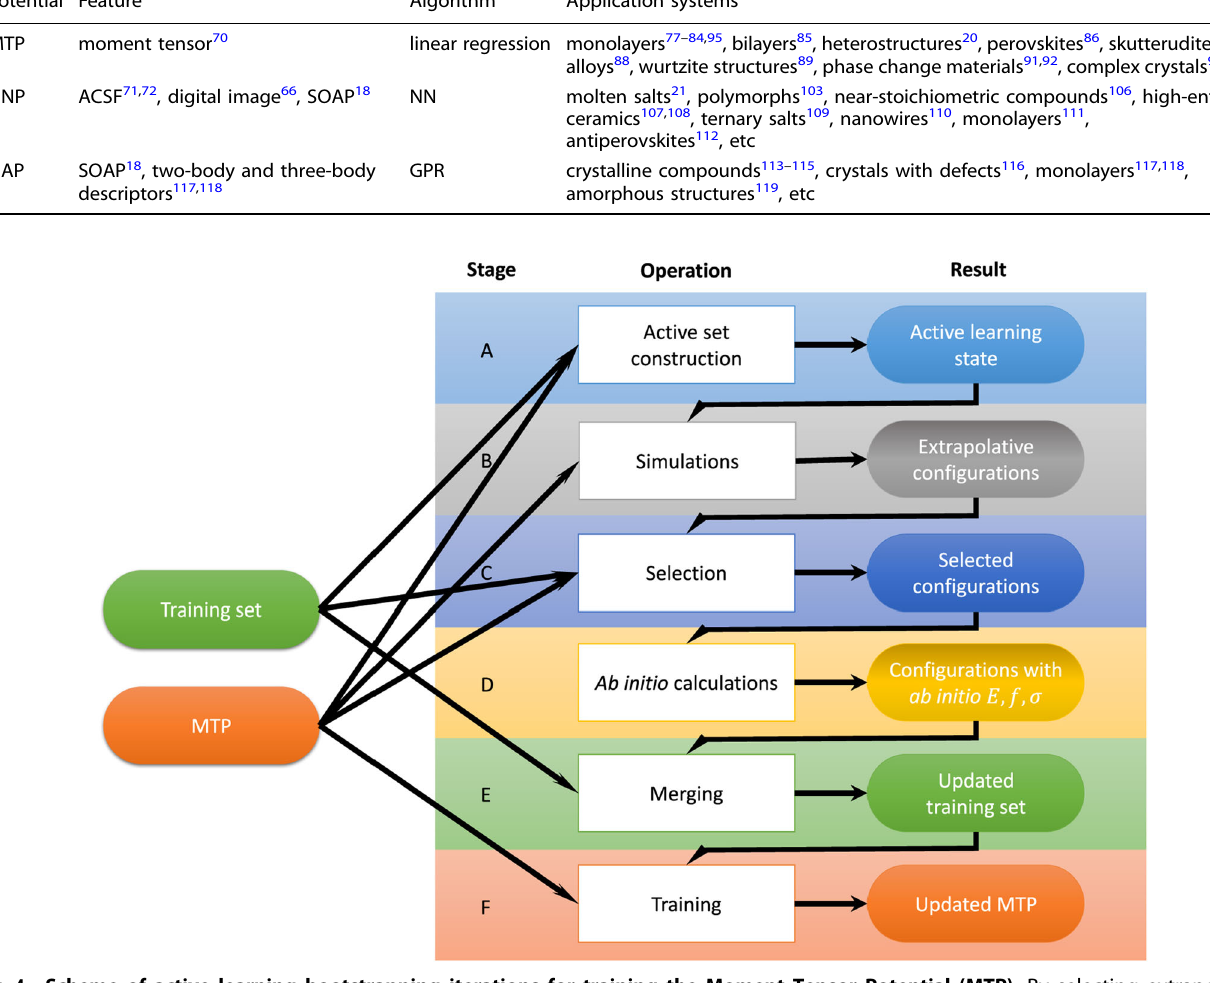
Table 2. Summary of widely adopted machine learning potentials for indirectly predicting lattice thermal conductivities. Potential Feature